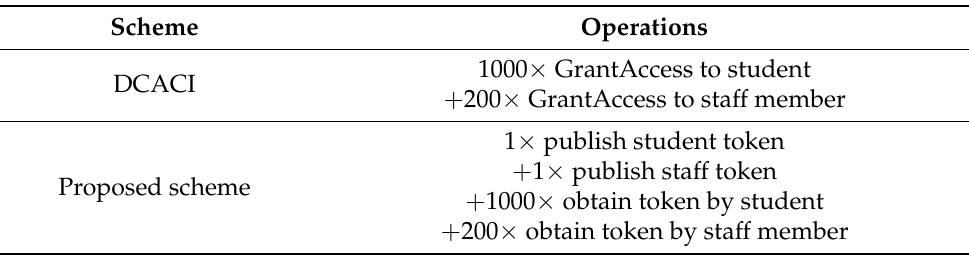
Figure 26. Comparison with DCACI: total execution time of authorizing 1000 students and 200 staff members. Table 4. Operations to authorize 1000 students and 200 staff